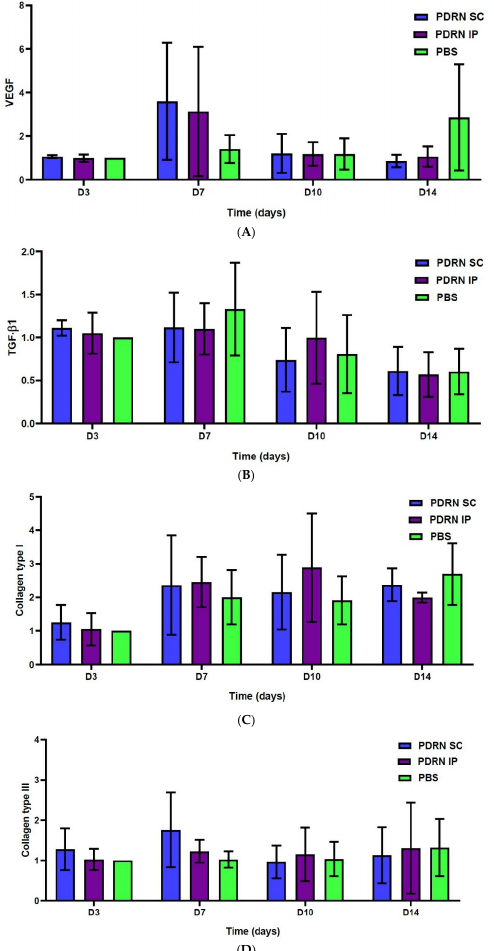
Figure 5. Results of the Western blotting analysis. ( A ) At 7 days, the PDRN SC group showed a significantly greater expression of VEGF as compared with the PBS group ( p < 0.0001). Of note, at 7 days, the PDRN SC group showed a significantly greater expression of VEGF as compared with the PDRN IP group ( p < 0.0001). ( B ) At 10 days, the PDRN SC group showed a significantly lower expression of TGF- β 1 as compared with the PBS group ( p < 0.0001). Of note, at 10 days, the PDRN SC group showed a significantly lower expression of TGF- β 1 as compared with the PDRN IP group ( p < 0.0001). ( C ) At 7 and 10 days, the PDRN SC and PDRN IP groups showed a significantly greater expression of collagen type I as compared with the PBS group ( p <0.0001). ( D ) At 7 days, the PDRN SC group showed a significantly greater expression of collagen type III as compared with the PBS group ( p <